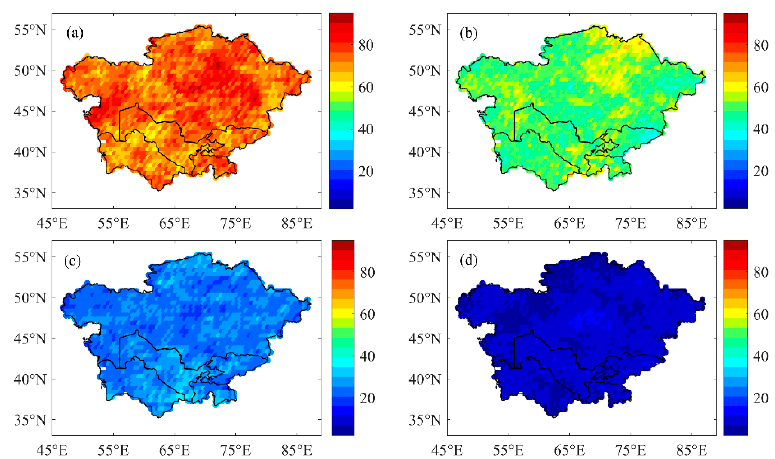
Figure 4. The spatial distribution of drought frequency in CA from 1961 to 2017: ( a ) slight; ( b ) moderate; ( c ) severe; ( d ) extreme.